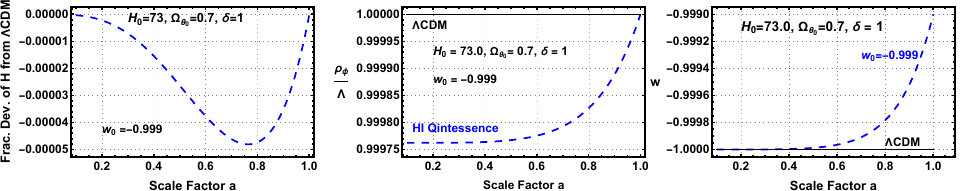
Figure 15. The evolution of the δ = 1, w 0 = − 0.999. Hubble parameter, dark energy density, and dark energy EoS. Note that unlike Figure 8, the fractional deviation of the HI Hubble parameter from Λ CDM is shown rather than the